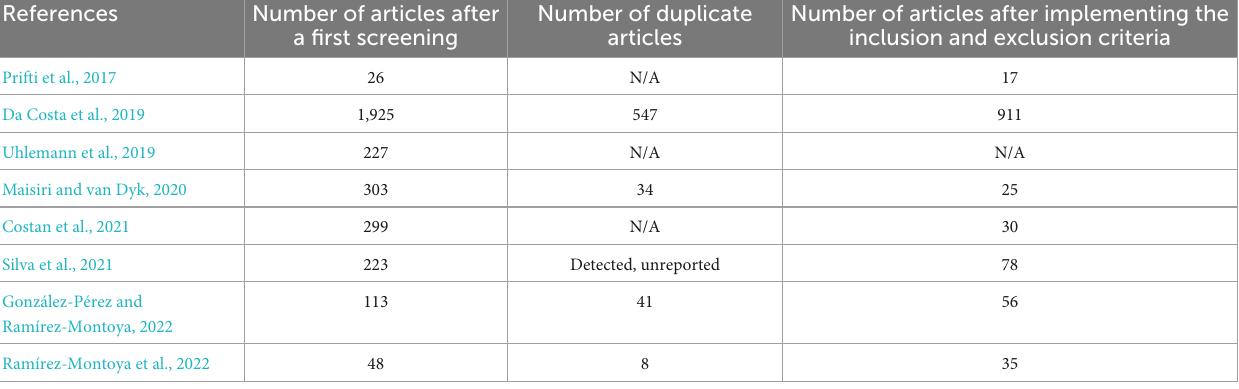
TABLE 4 Additional elements incorporated into the core components of E.D. 4.0 presented by Miranda et al. (2021) to obtain the combined reference